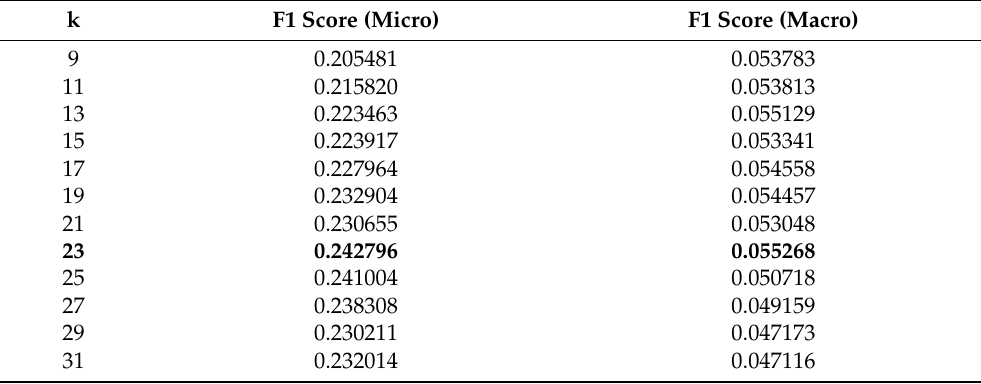
Table A2. KNN tuning: how the F1 score varied (micro and macro averaged) as the value of k was altered. Tests performed using the constant processing pipeline. Selected k value shown in bold.